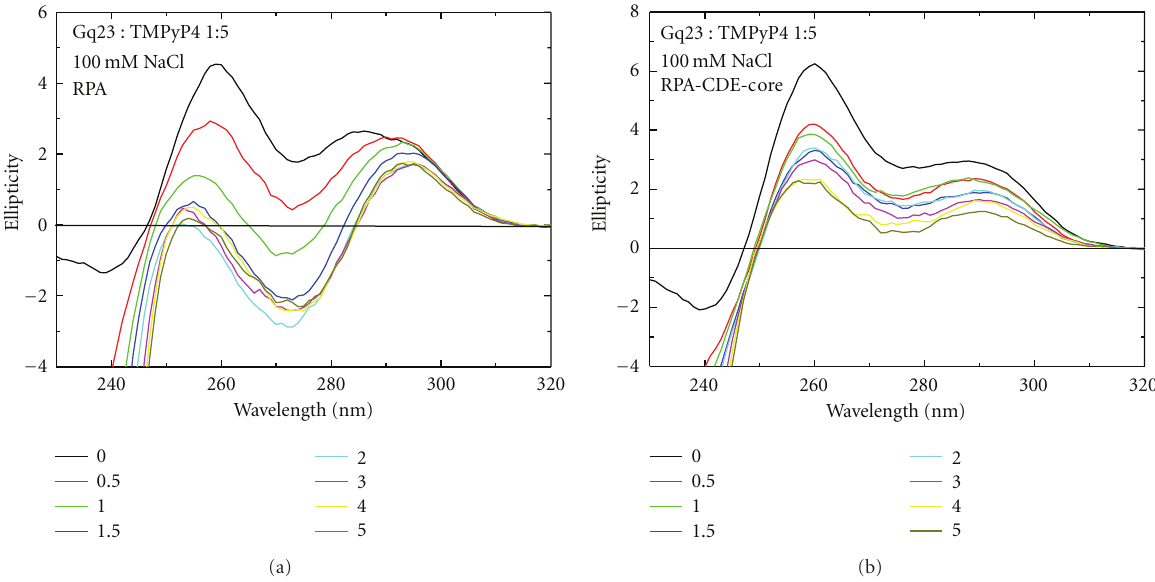
Figure 6: E ff ect of TMPyP4 and RPA on Gq23 in the presence of Na + ions. (a) CD spectra of Gq23 at a 1: 5 molar ratio of Gq23 :TMPyP4 (black line). Spectra were collected upon addition of increasing molar ratios (0–5) of RPA or (b) RPA-CDE-core. All spectra were recorded in a bu ff er containing